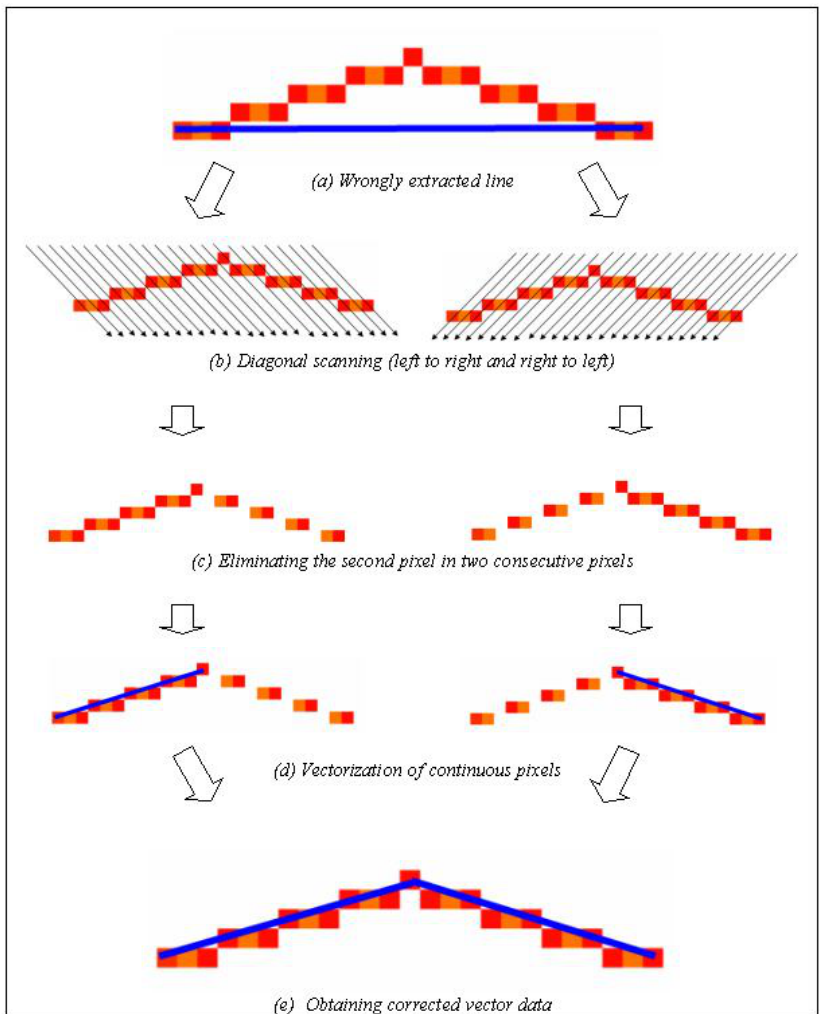
Figure 5. Correction of wrong extracted lines by using diagonal scanning